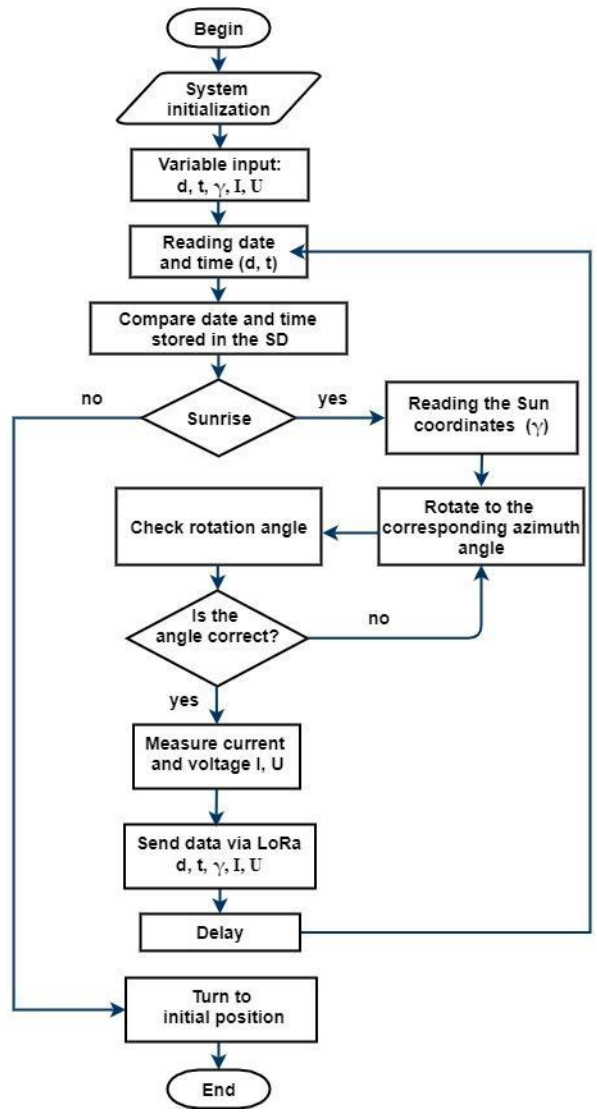
Figure 7. Algorithm for a single-axis solar tracker based on astronomical data.